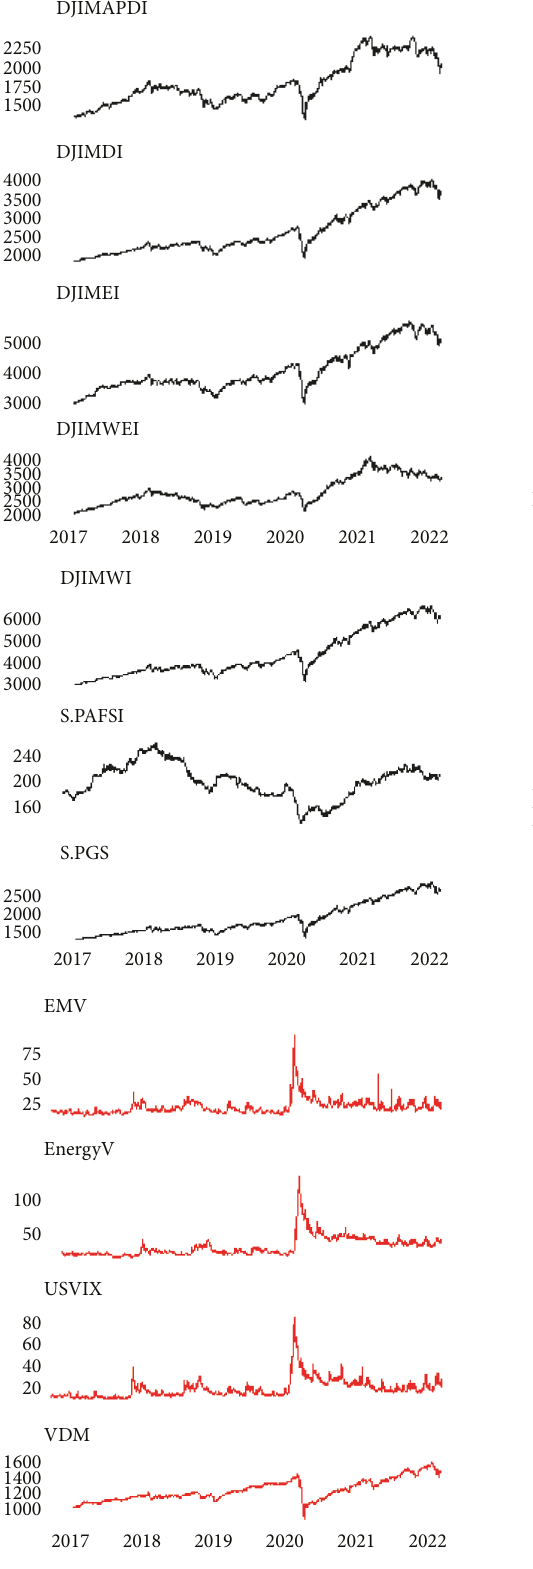
Figure 1: Price and returns series plots for Islamic stocks and volatility